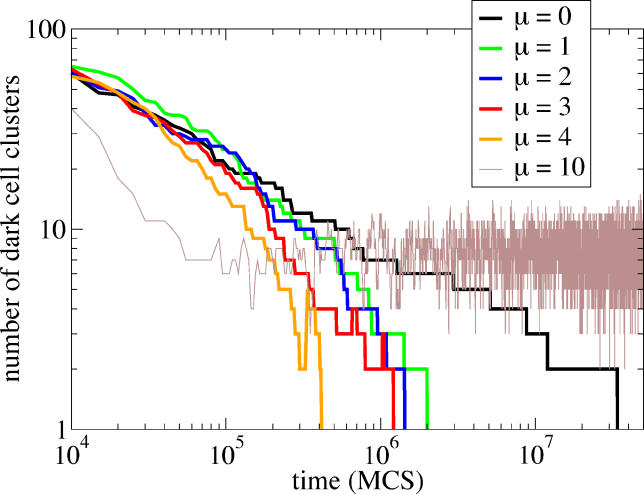
Rates of Cell Sorting for Different Chemotactic StrengthsInfluenced by non-specific chemotaxis, cell sorting can become 10–100× faster than for pure differential adhesion. Parameters are Jl,l = 5, Jd,l = 9, Jd,d = 8 (yielding γ = 2.5), Vl = Vd = 30, T = 6, λ = 12, and Hb = 0.8.